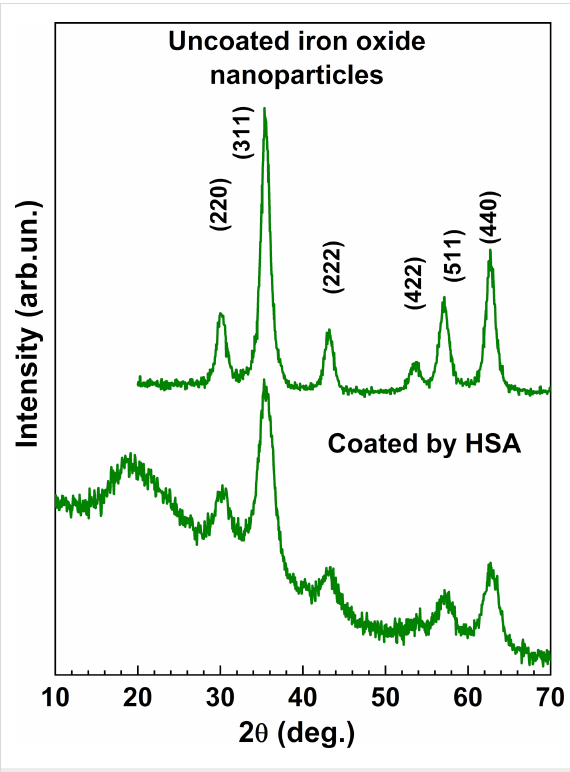
Figure 1: XRD patterns of coated and uncoated magnetic nanoparti- cles.